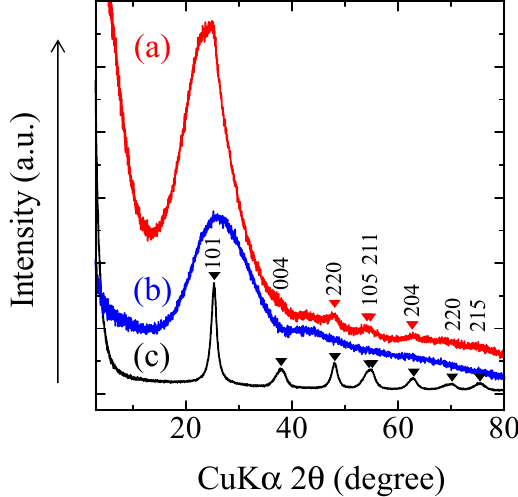
Figure 1. SEM images of the non-porous and porous glass fibers before (left and center panels) and after (right panel) TiO 2 coating.